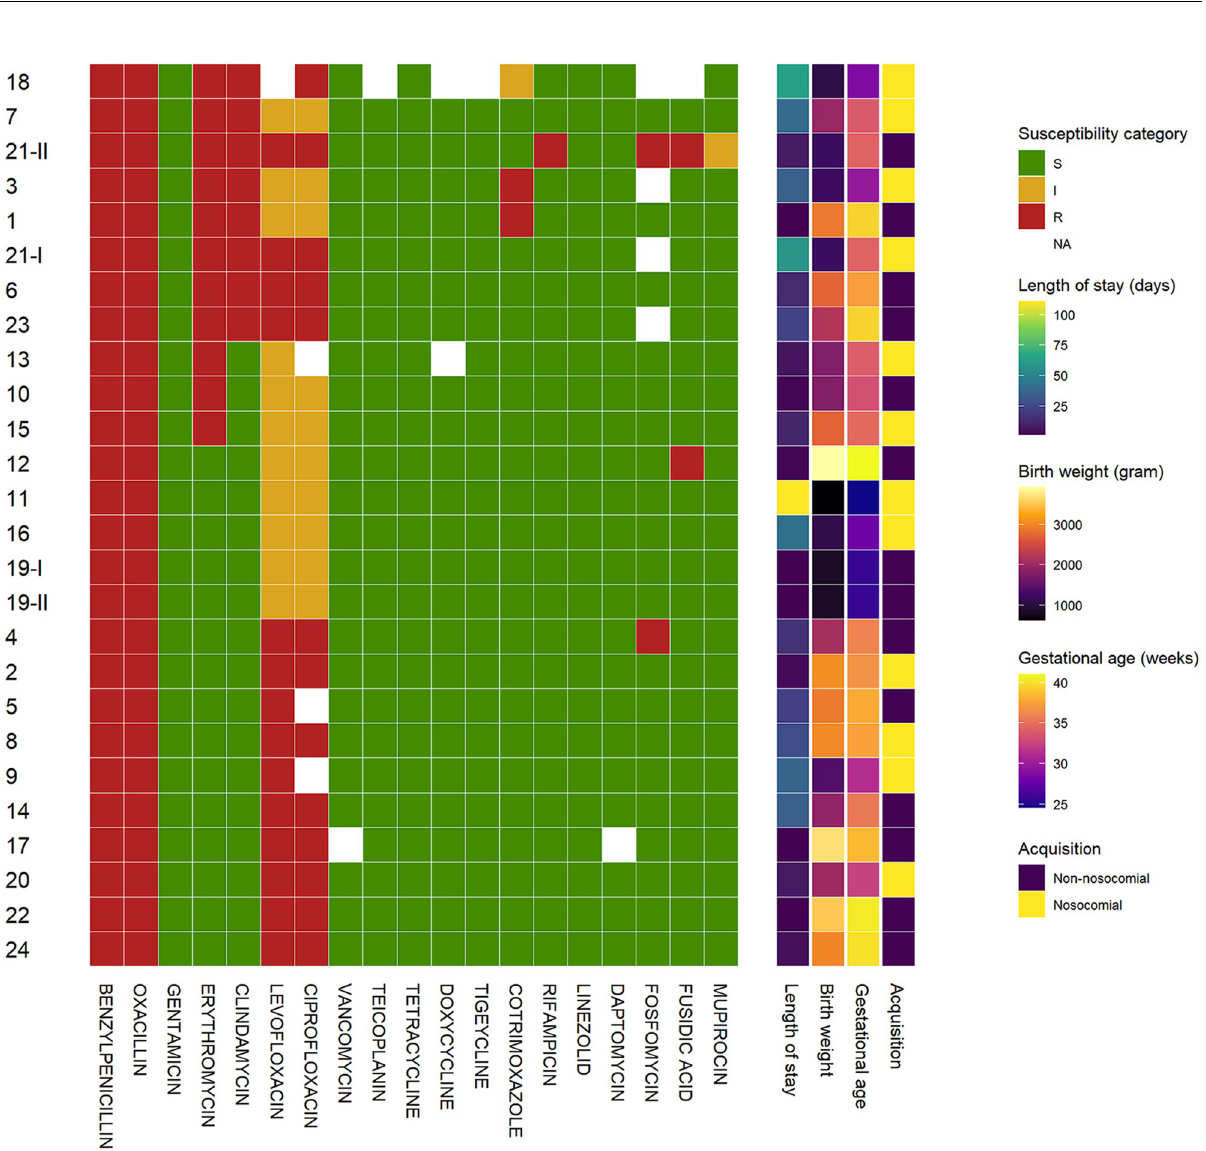
Fig 1. Antibiotic susceptibility pattern of the patients’ MRSA isolates (n = 24 patients, n = 26 MRSA isolates). Arabic numbers indicate patients. For patient 19 and patient 21, two isolates from each two different hospital stays are shown (Roman numbers). Row order is based on the hierarchical clustering of susceptibility patterns using maximum distance and Ward’s